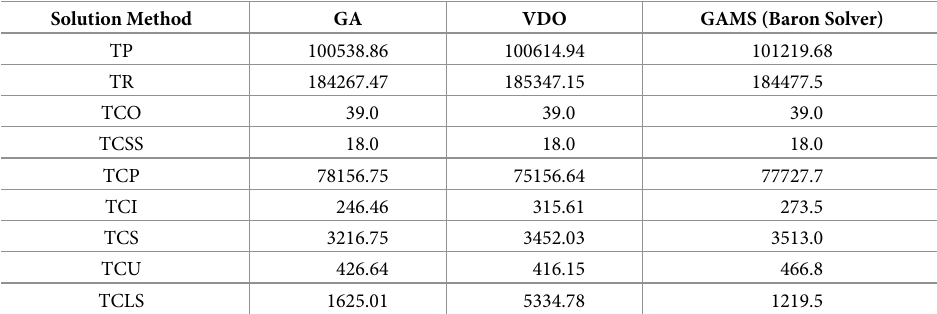
Table 9. The costs and incomes of designing the system with different solving methods.